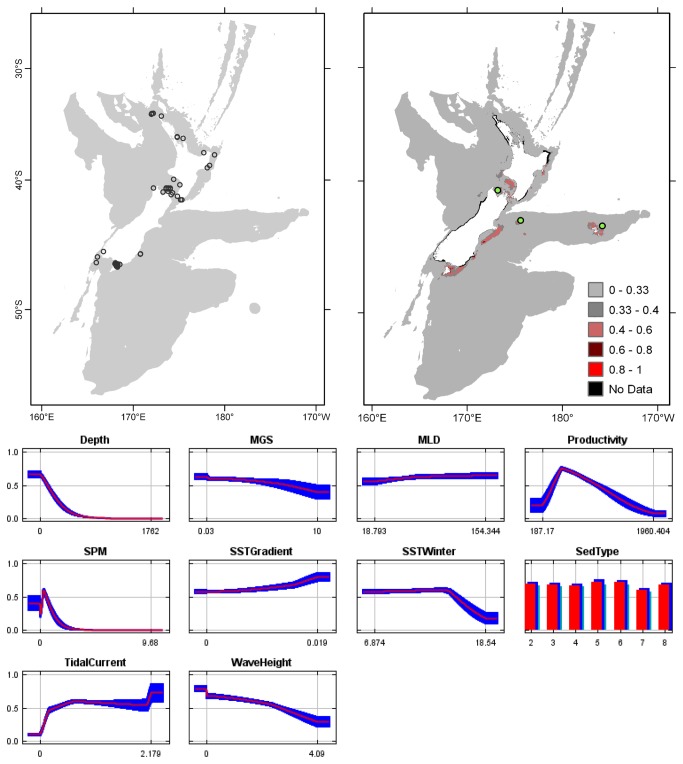

Celleporariaagglutinans

 known distribution (left), predicted suitable habitat (right), and fitted responses curves (marginal).For the predicted distribution, logistic probabilities less than the 10th percentile presence value indicated cells were unsuitable habitat. Probabilities of 0.4–0.6 indicated habitat suitability typical of the presence records, values of 0.6–0.8 and 0.8–1 indicated favourable and highly suitable habitat, respectively. Black cells had missing data in one or more environmental layer. Independent records are layed over the predictions. Marginal response curves show how the prediction changes for different values of each variable when all other variables were at their average sample value. Individual response curves are shown in Figure S3. For the categorical variable Sediment type: 1 = deep ocean clays; 2 = calcareous gravel; 3 = volcanic; 4 = calcareous mud; 5 = gravel; 6 = mud; 7 = sand; 8 = calcareous sand.